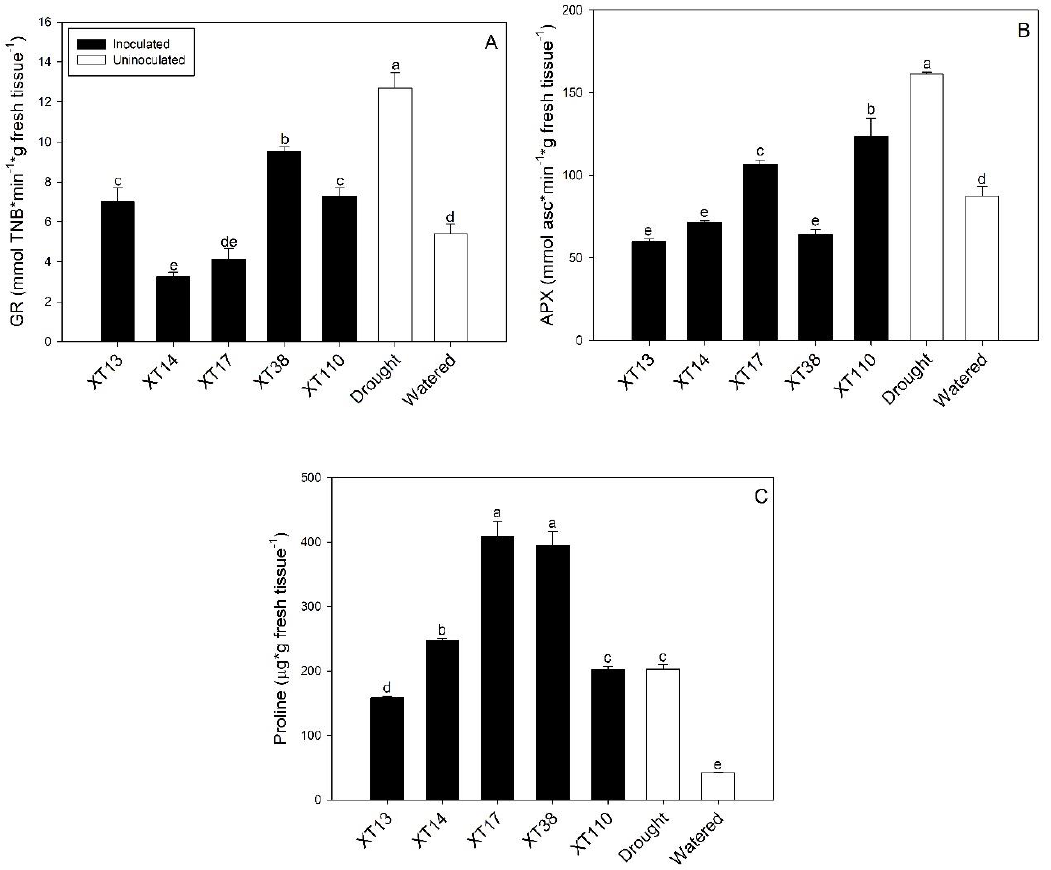
Figure 3. Effect of drought and Bacillus spp. inoculation on maize plants expressed as: ( A ) glutathione reductase (GR) activity, ( B ) ascorbate peroxidase (APX) activity, and ( C ) proline accumulation. Whiskers represent the standard deviation. Bars followed by the same letter are not significantly different at p ≤ 0.05 by Tukey´s test.